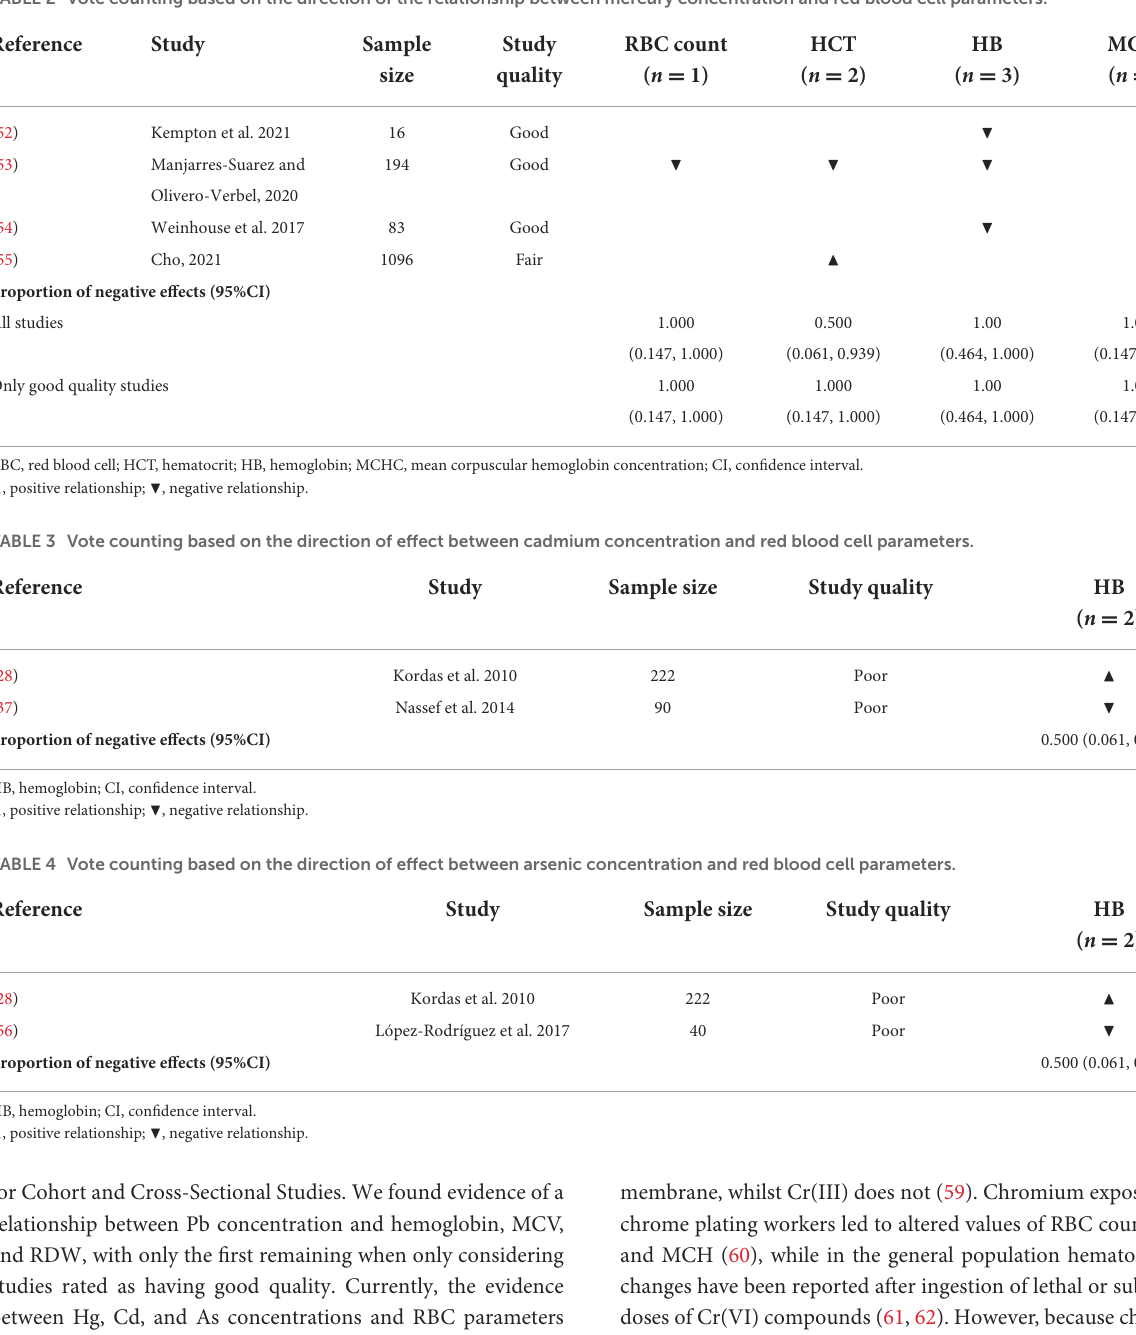
TABLE 2 Vote counting based on the direction of the relationship between mercury concentration and red blood cell parameters.